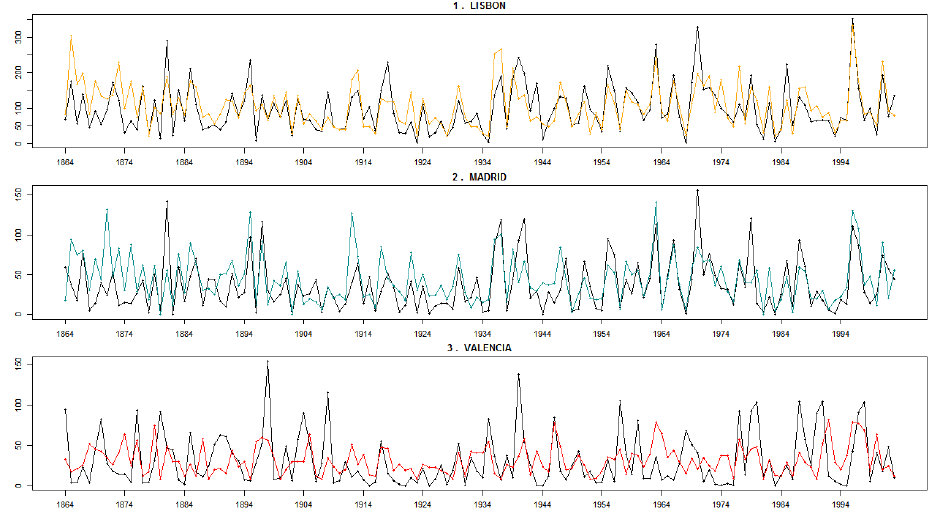
Figure 9. January observed monthly precipitation (black line) and predicted precipitation (colour line) for the three long term stations of Valencia, Madrid and Lisbon.